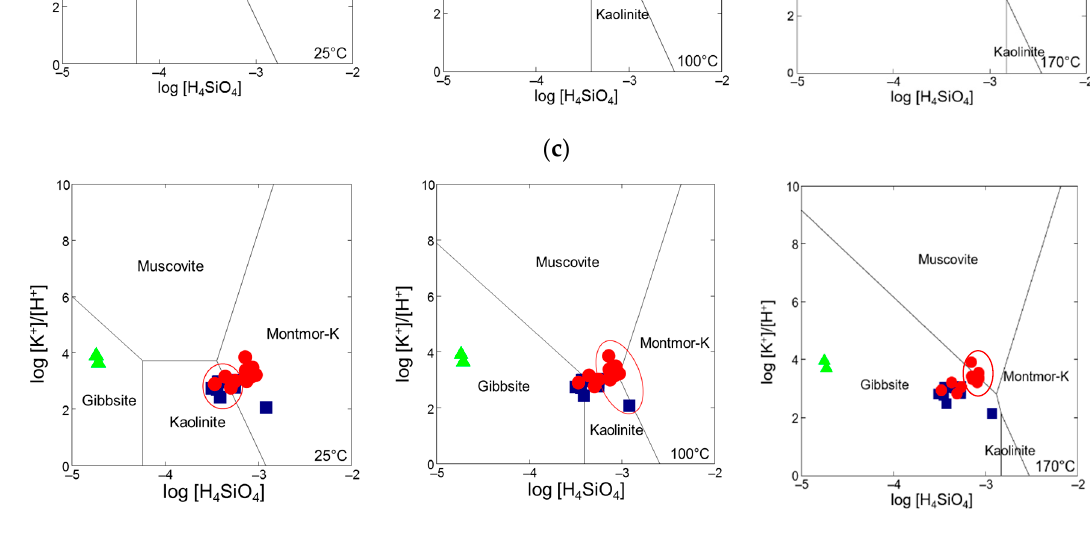
Figure 9. [M z+ ]/[H + ] z – [H 4 SiO 4 ] activity-activity diagrams at 25 °C, 100 °C, and 170 °C for ( a ) Ca; ( b ) Mg; ( c ) Na; ( d ) K. Symbols are as for Figure 3.